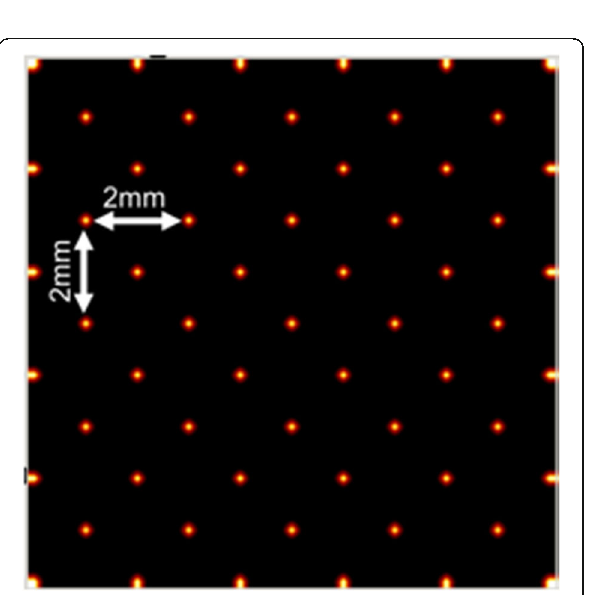
Fig. 2 (abstract A10). Irradiation pattern to obtain spatial resolution. Horizontal and vertical distance between points is 2mm